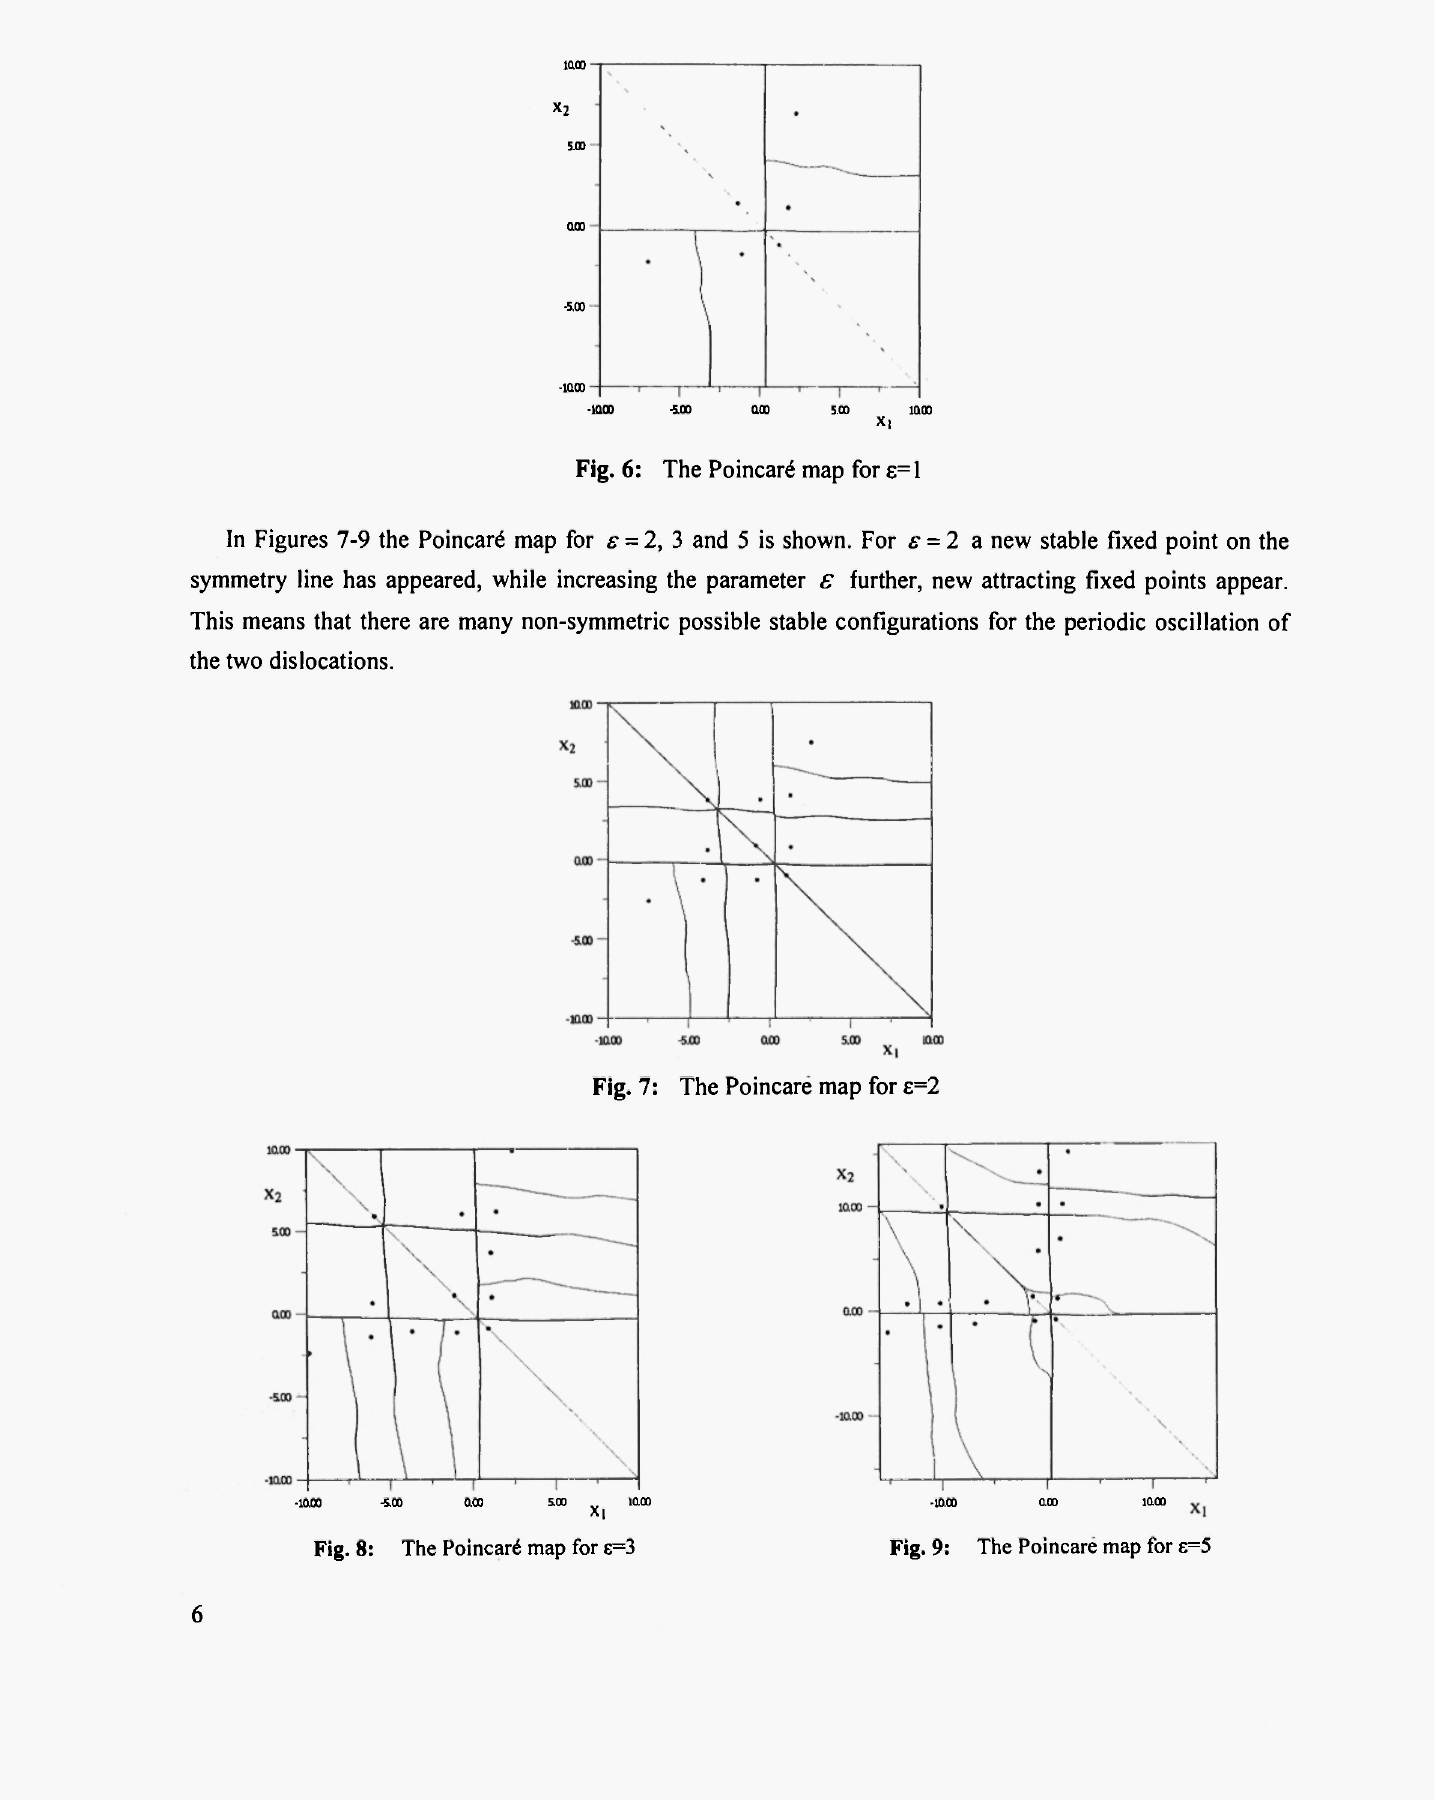
Fig. 8: The Poincari map for ε=3 Fig. 9: The Poincare map for